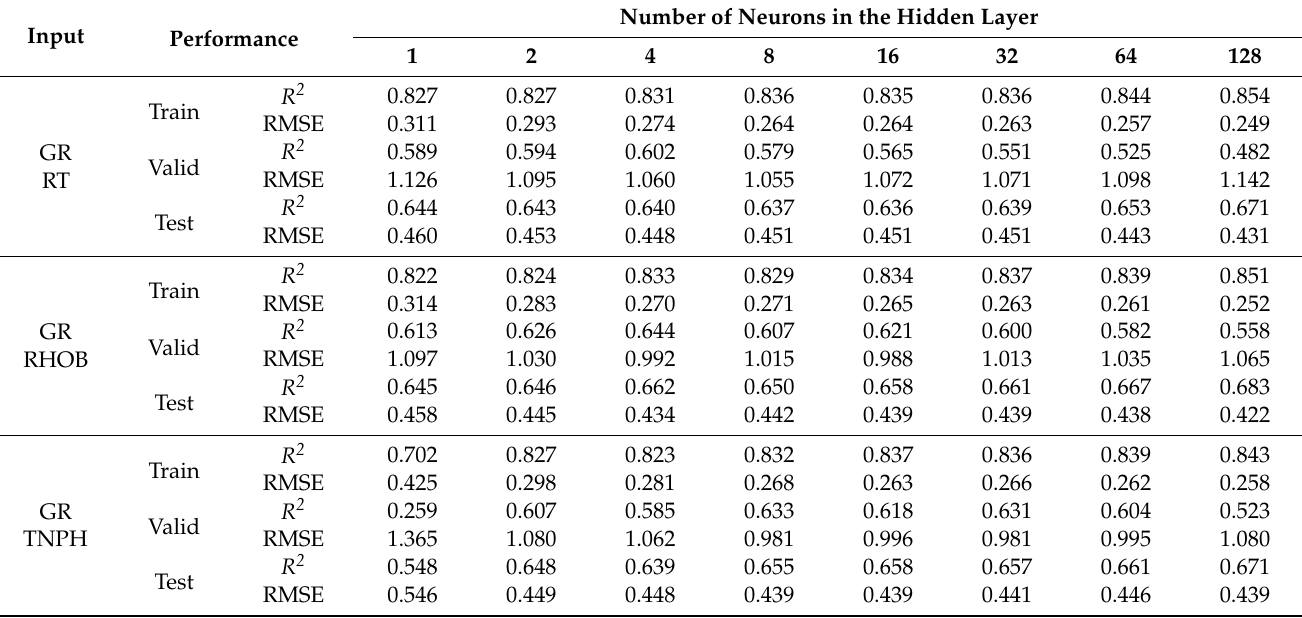
Table A2. Performance for generating synthetic Vp using two input